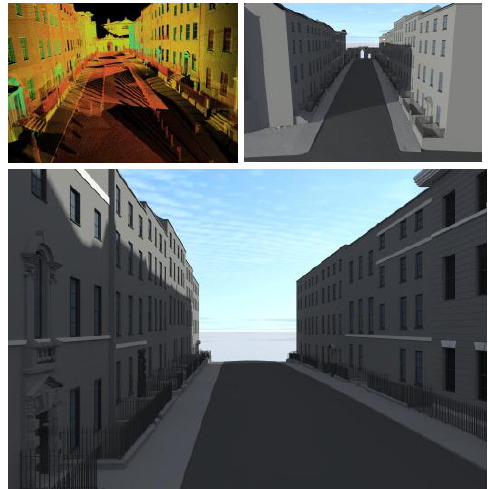
Figure 16. Point cloud and subsequent HBIM model created using parametric library objects and procedural